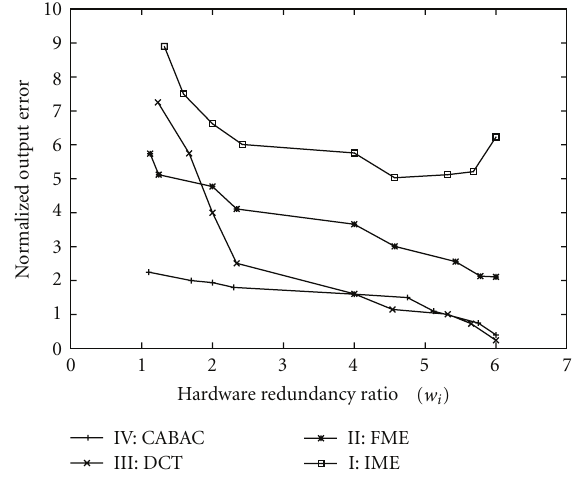
Figure 4: Output error versus hardware redundancy ratio w i for di ff erent